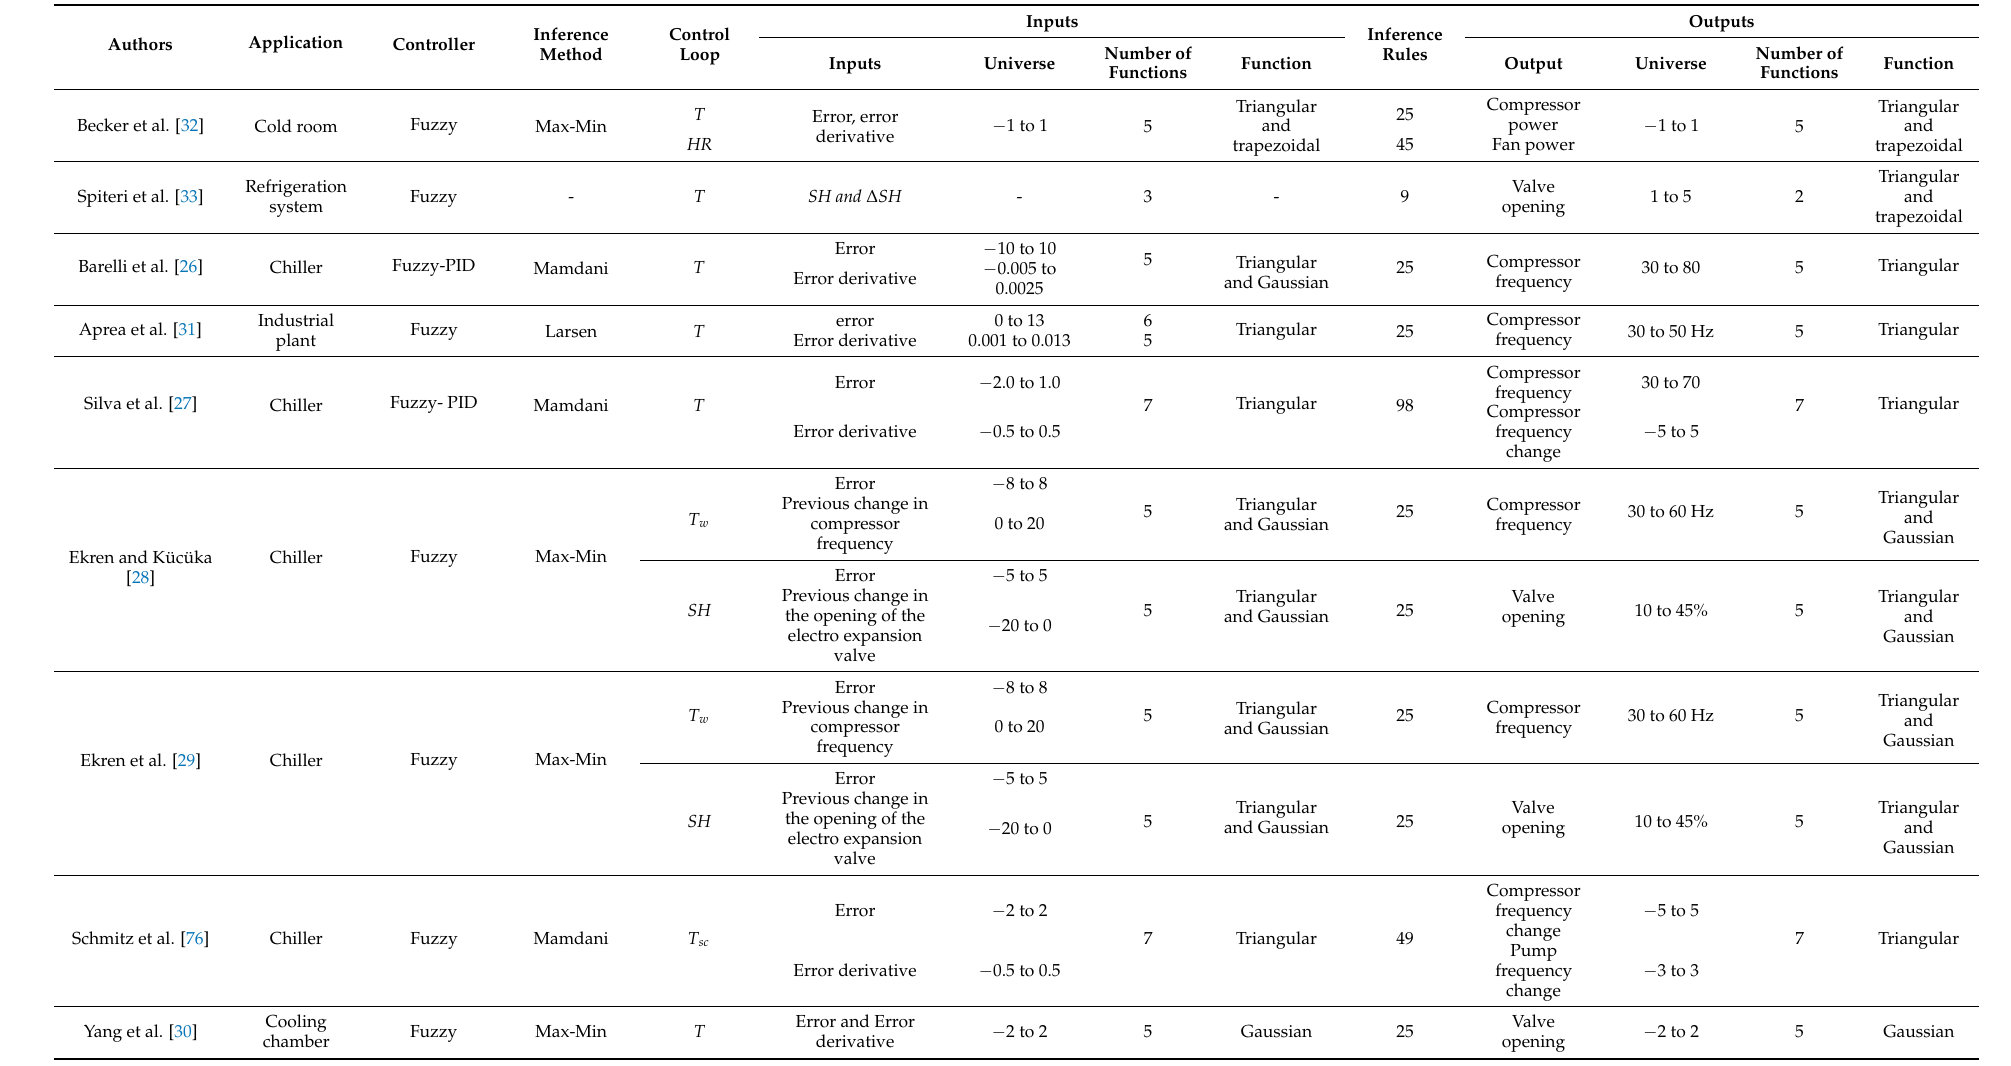
Table 2. Fuzzy driver application in